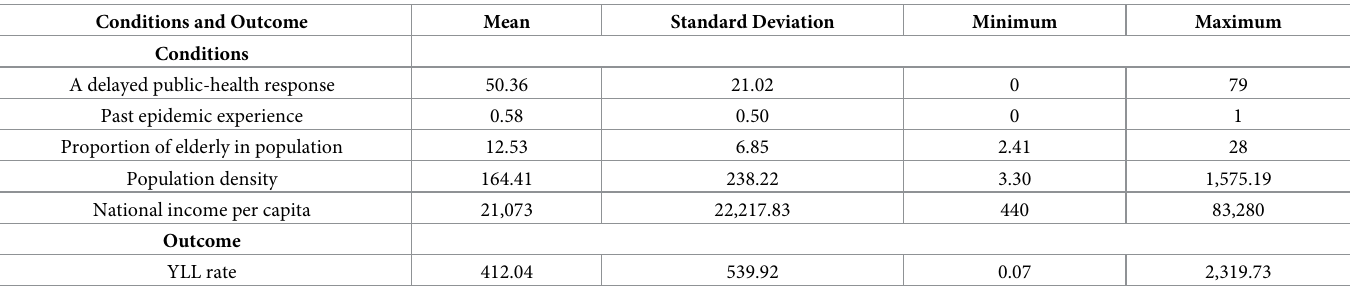
Table 1. Descriptive statistics of conditions and